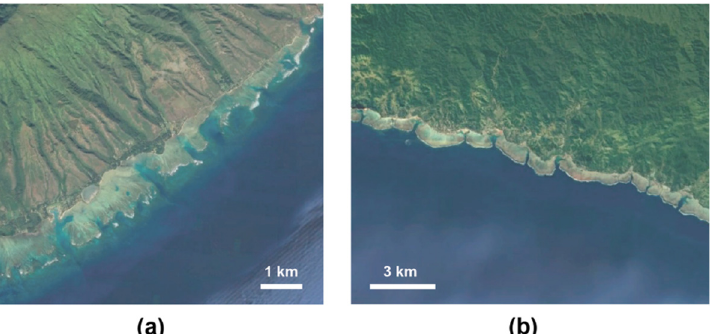
Figure 1. Examples of shore-normal channels in fringing coral reef platforms. ( a ) Moloka’i, Hawai’i. ( b ) Viti Levu, Fiji.